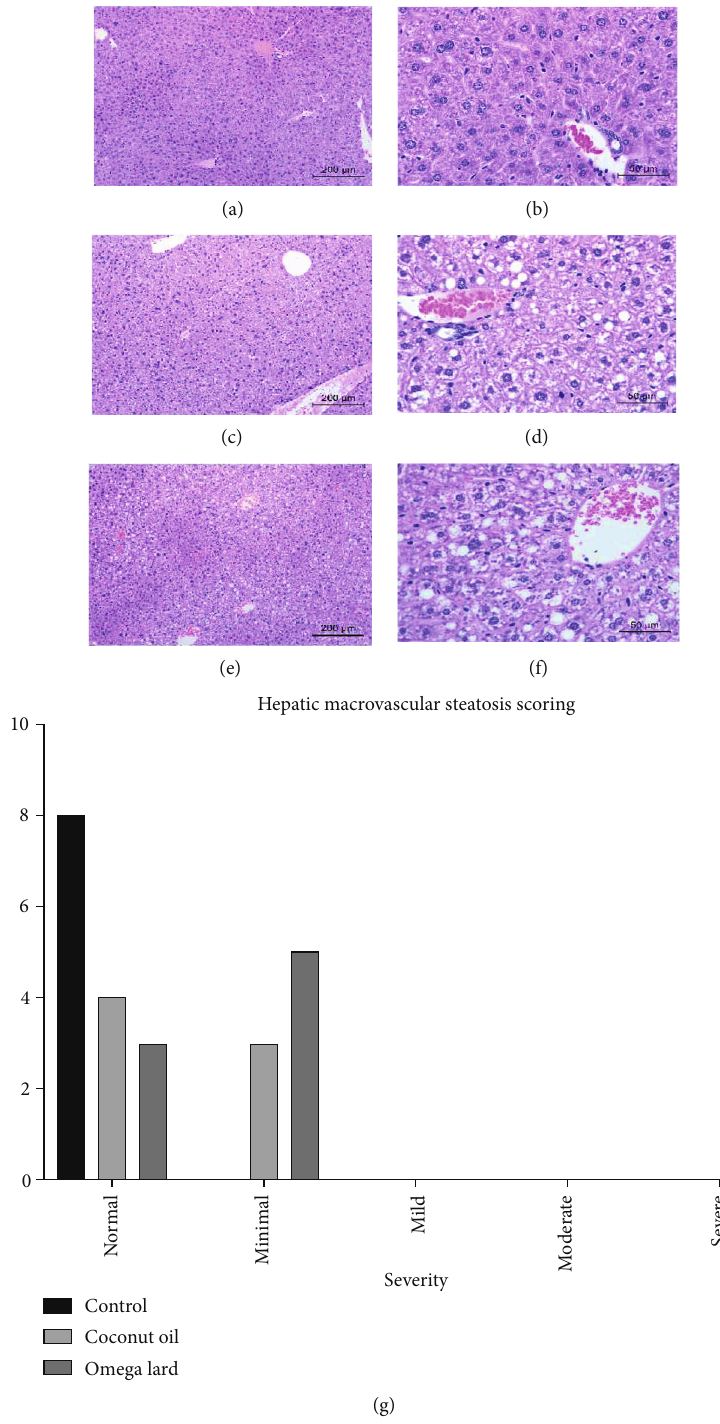
Figure 3: Hepatic macrovesicular steatosis. The histopathological staining of liver tissues showing hepatic macrovesicular steatosis in the control group at 10x (a) and 40x (b), coconut oil-fed group at 10x (c) and 40x (d), omega lard-fed group at 10x (e) and 40x (f) and the hepatic macrovesicular steatosis scores (g). Increased incidences of hepatic macrovesicular steatosis were observed in both the coconut oil- and omega lard-fed groups compared to the control group. The hepatic macrovesicular steatosis scores were consistent, showing a slightly increased incidence of steatosis in both the coconut oil- and omega lard-fed groups. No signi fi cant di ff erence between the coconut oil- and omega lard-fed groups was observed (chi-square test, P < 0 : 05 ). The number of mice is presented on the y -axis and the severity of hepatic macrovesicular steatosis on the x -axis. Liver tissues were harvested from all animals at the end of the experiment (four weeks). The number of animals was 8, 7, and 8 in the control, coconut oil-fed, and omega lard-fed groups,